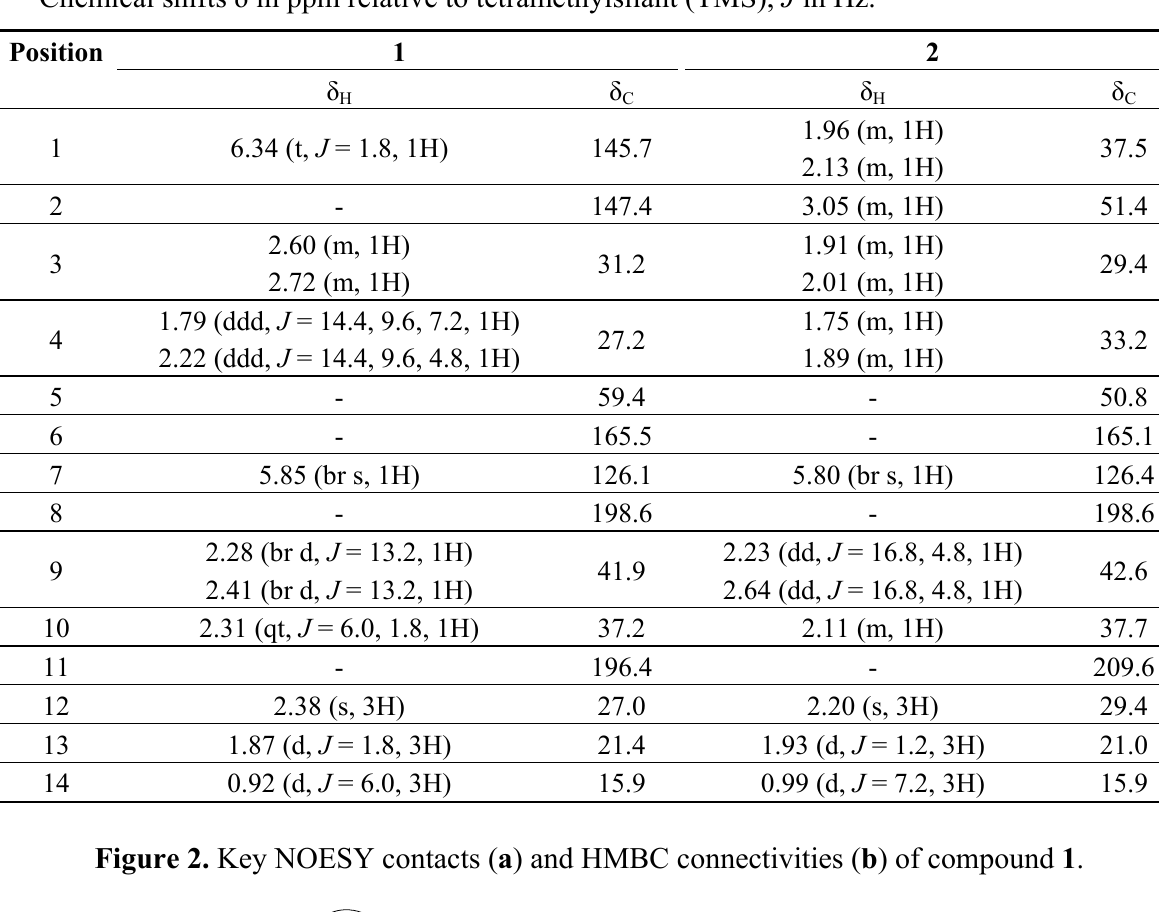
) of compounds 1 and 2 . 3